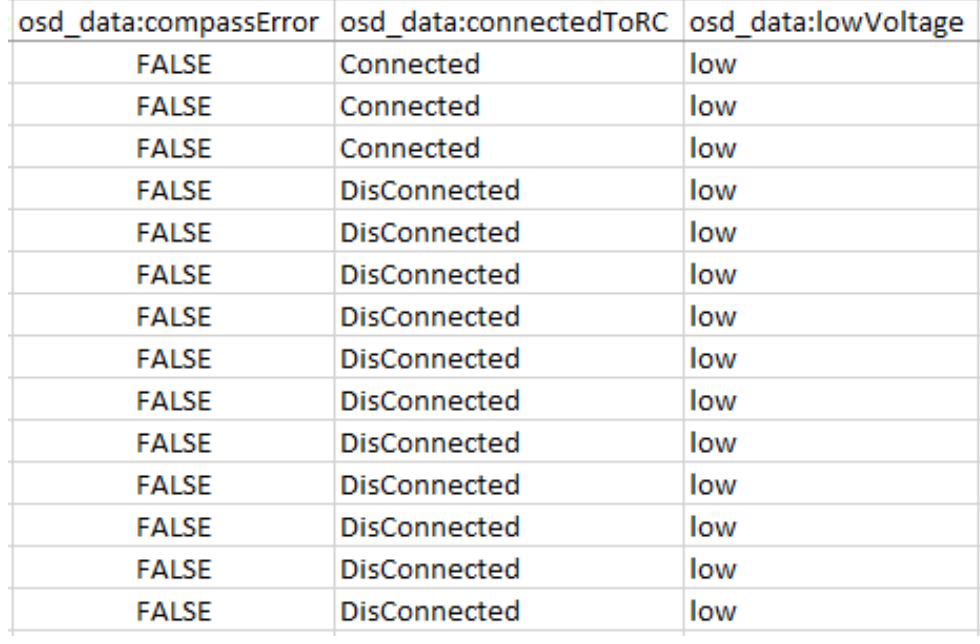
Figure 8. Drone and radio control